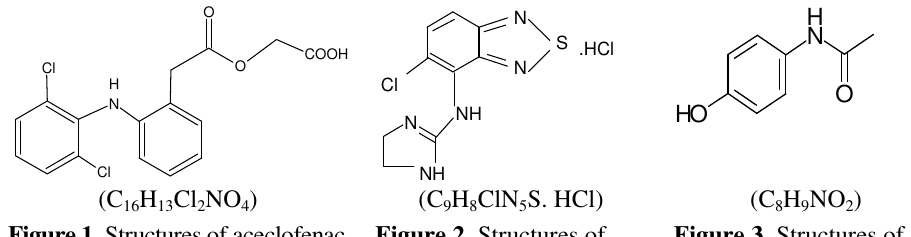
Figure 3. Structures of tizanidine hydrochloride.